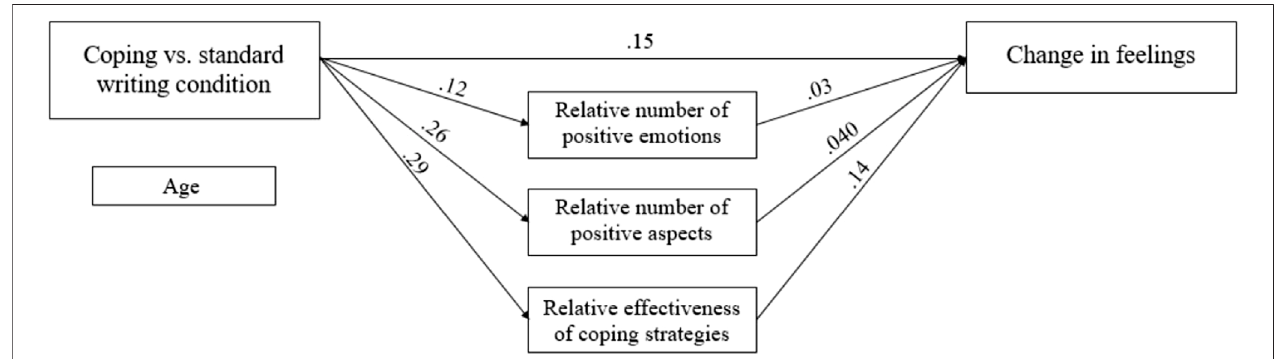
FIGURE 2 | Mediation model: coping vs. standard writing